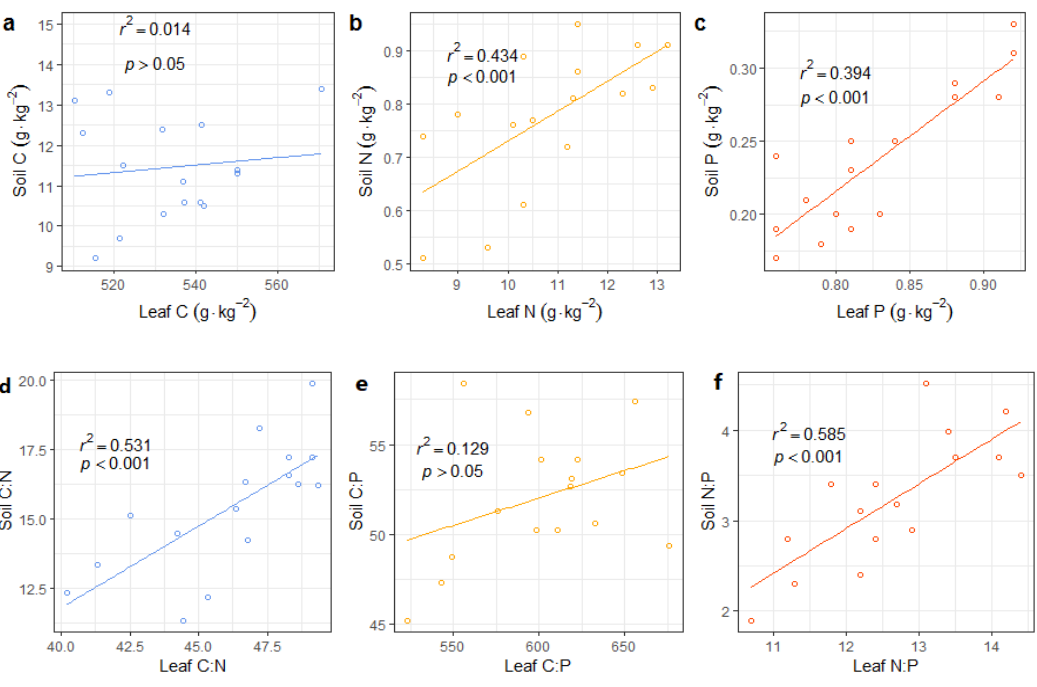
Figure 4. Correlations of leaf C, N, and P content( a – c ) and C:N, C:P, and N:P ratios( d – f ) with soil C, N, and P content and stoichiometry.